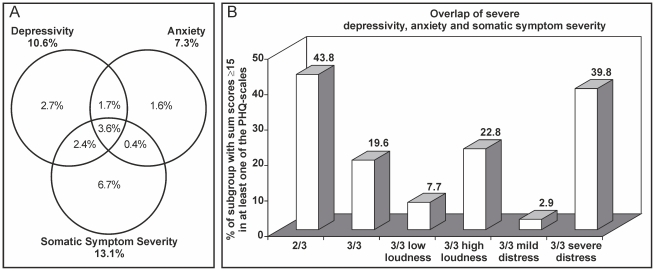
Comorbidity of depressivity, anxiety, and somatic symptom severity derived from scores of the Patient Health Questionnaire (PHQ).
A: Somatic symptom severity was most common (13.1% of whole sample) followed by depressivity (10.6%) and anxiety (7.3%). 3.6% of the whole sample were affected by elevated levels of depressivity, anxiety and somatic symptom severity at the same time, and an additional 4.5% showed elevated levels in two scales. B: The 726 participants with scores of 15 or above in at least one of the three PHQ scales (1/3) were set to 100%. Of these, 318 (43.8%) exhibited severe levels in at least 2 PHQ-scales (2/3), while 142 (19.6%) had severe levels in all scales (3/3). The percentage of participants with scores of 15 and above in all three scales (3/3) was least common in the subgroup with mild tinnitus-related distress (2.9%), while it was most common in the subgroup with severe tinnitus-related distress with 39.8%. Differences between subgroups with low and high subjective loudness had the same direction, but were less pronounced. PHQ scales: PHQ-9 – depressivity, GAD-7 – anxiety, PHQ-15 – somatic symptom severity.